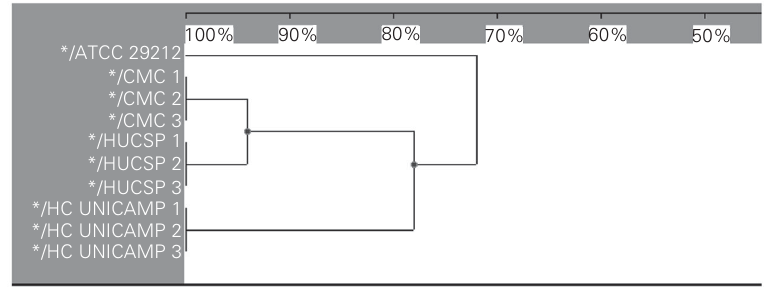
Figure 2. Dendrogram of Enterococcus faecalis VanA phenotype. The values were gener- ated from the Dice coefficient showing the similarity of E. faecalis vancomycin-resistant strains from Centro Médico de Campinas (CMC), Hospital das Clínicas, Universidade de São Paulo (HCUSP) and vancomycin-susceptible E. faecalis from Universidade Estadual de Campinas